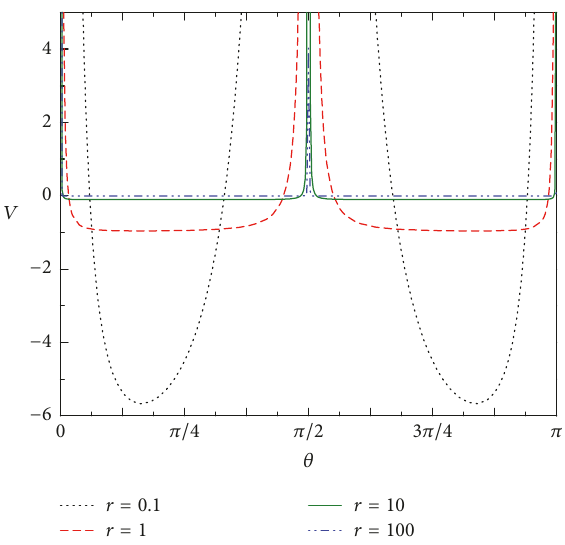
Figure 2: Potential function 𝑉(𝑟, 𝜃) versus 𝜃 at 𝑟 = 0.1, 1, 10, 100